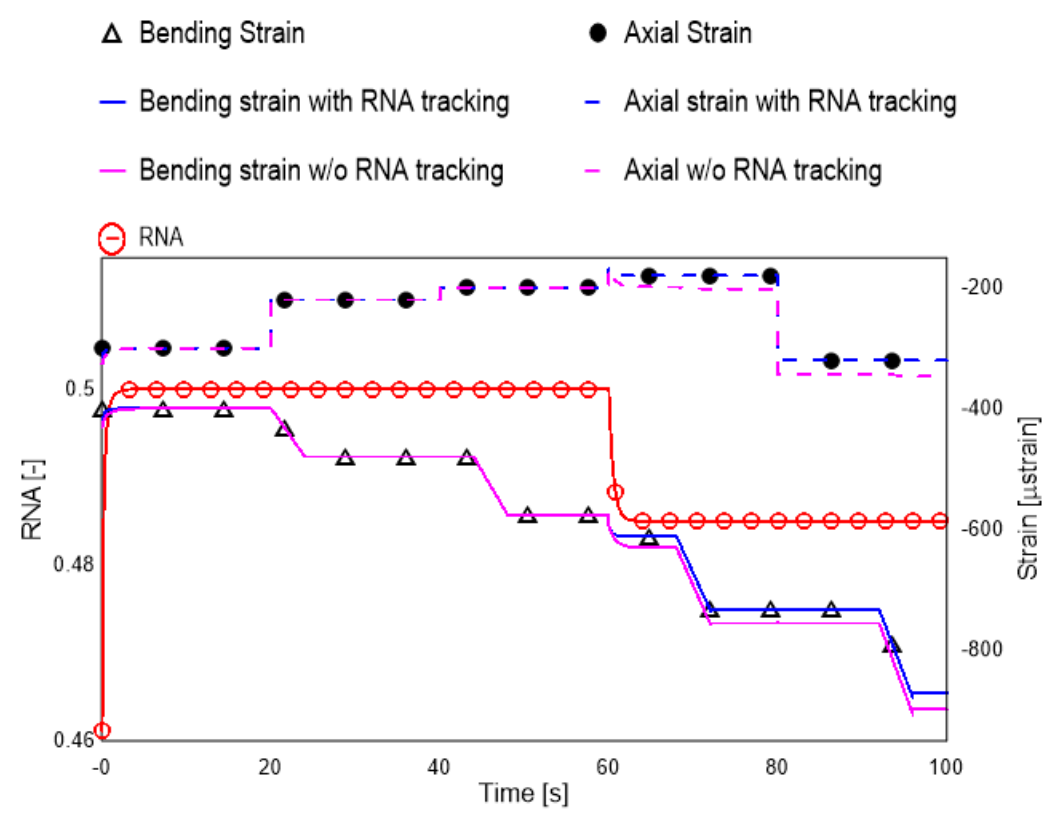
Figure 8. Need for RNA tracking in load